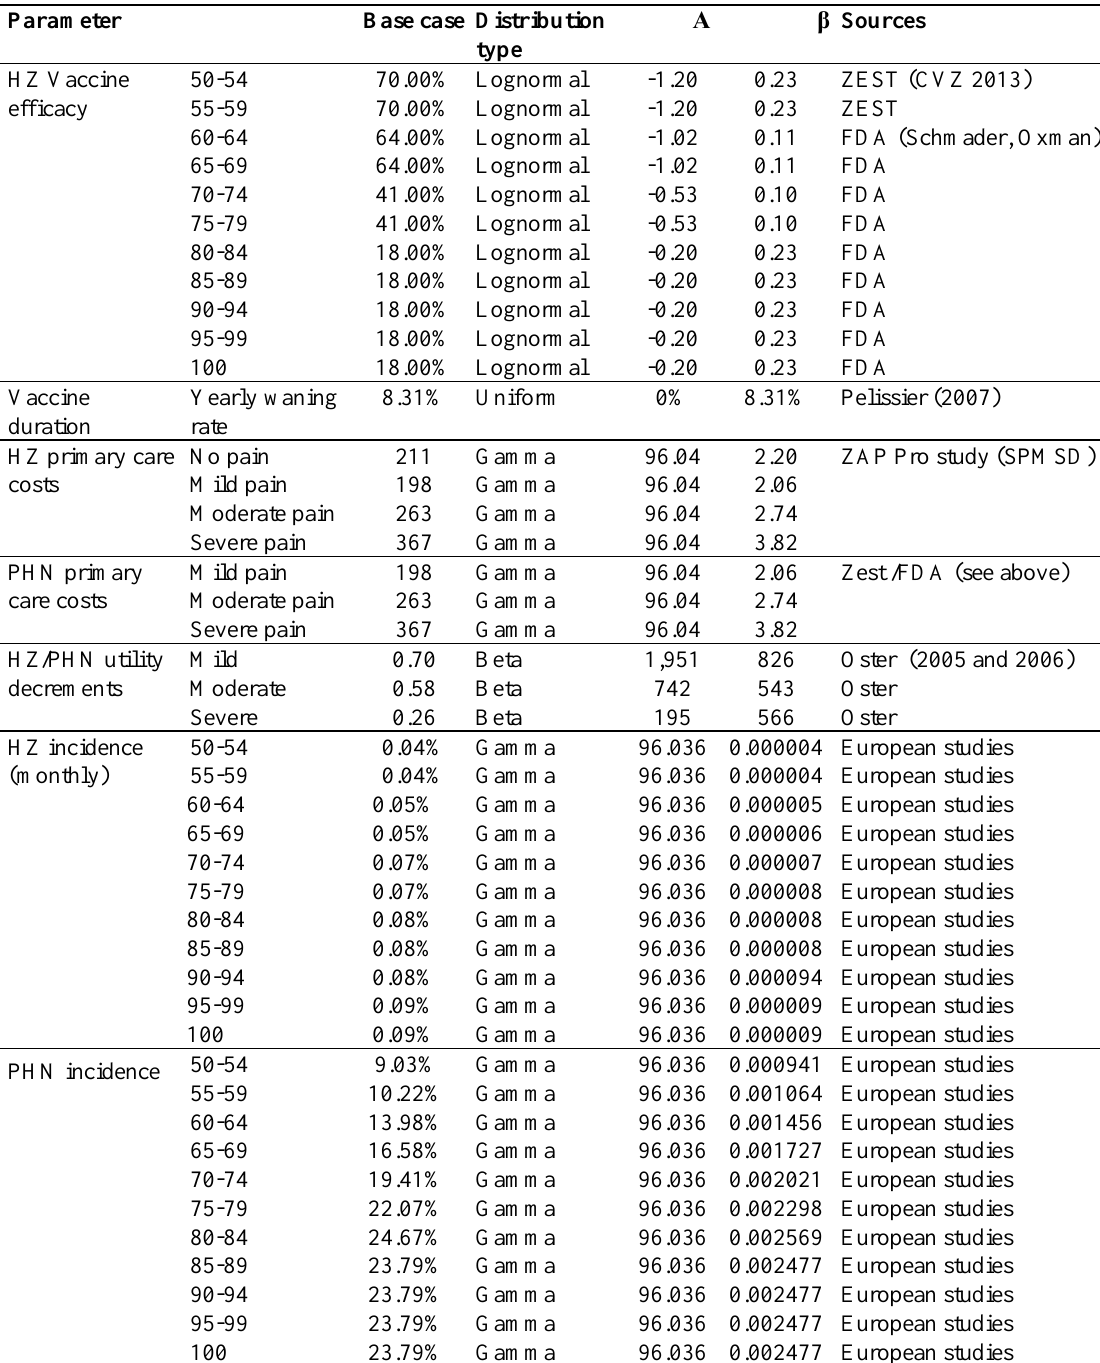
Table 6: Parameters for probabilistic sensitivity analysis